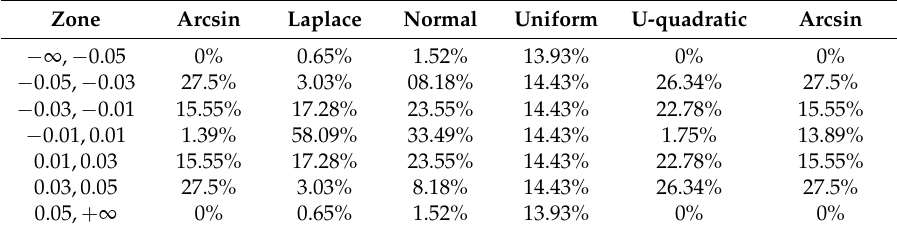
Table 3. Distribution of noises.